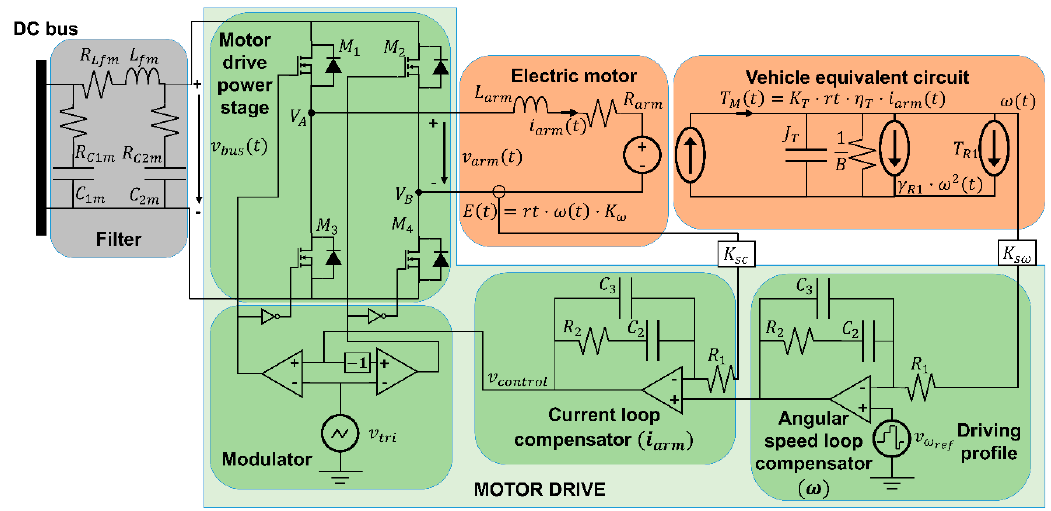
Figure 14. A system composed of the vehicle, electric motor, motor drive, and filter.